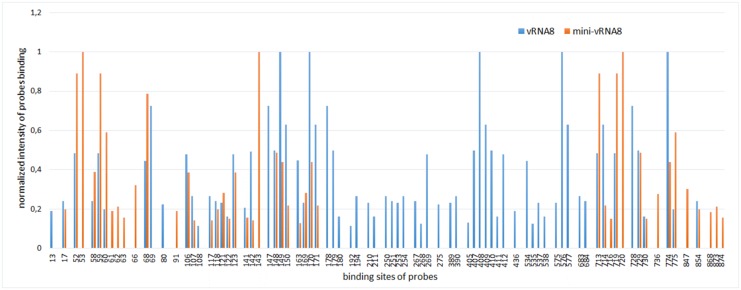
Aligned results of hybridization of vRNA8 (blue) and mini-vRNA8 (orange) to isoenergetic microarrays.All complementary sites for binding probes are shown and grouped in regions of binding.